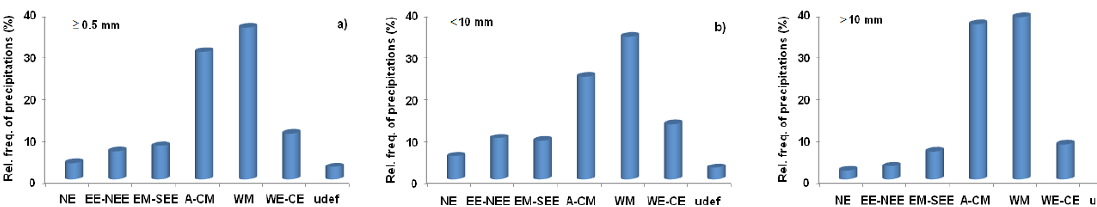
Figure 3. Relative frequency of the total number of days with precipitation a) greater than or equal to 0.5 mm, b) precipitation less than 10 mm and c) precipitation greater than or equal to 10 mm for Herceg